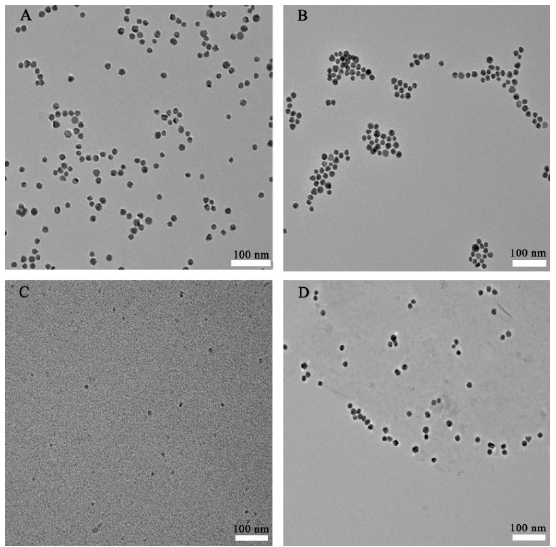
Figure 4. ( A ) TEM images of the original AuNPs; ( B ) TEM images of the AuNPs in the presence of melamine; ( C ) TEM images of the CPNs; ( D ) TEM images of the AuNPs in the presence of